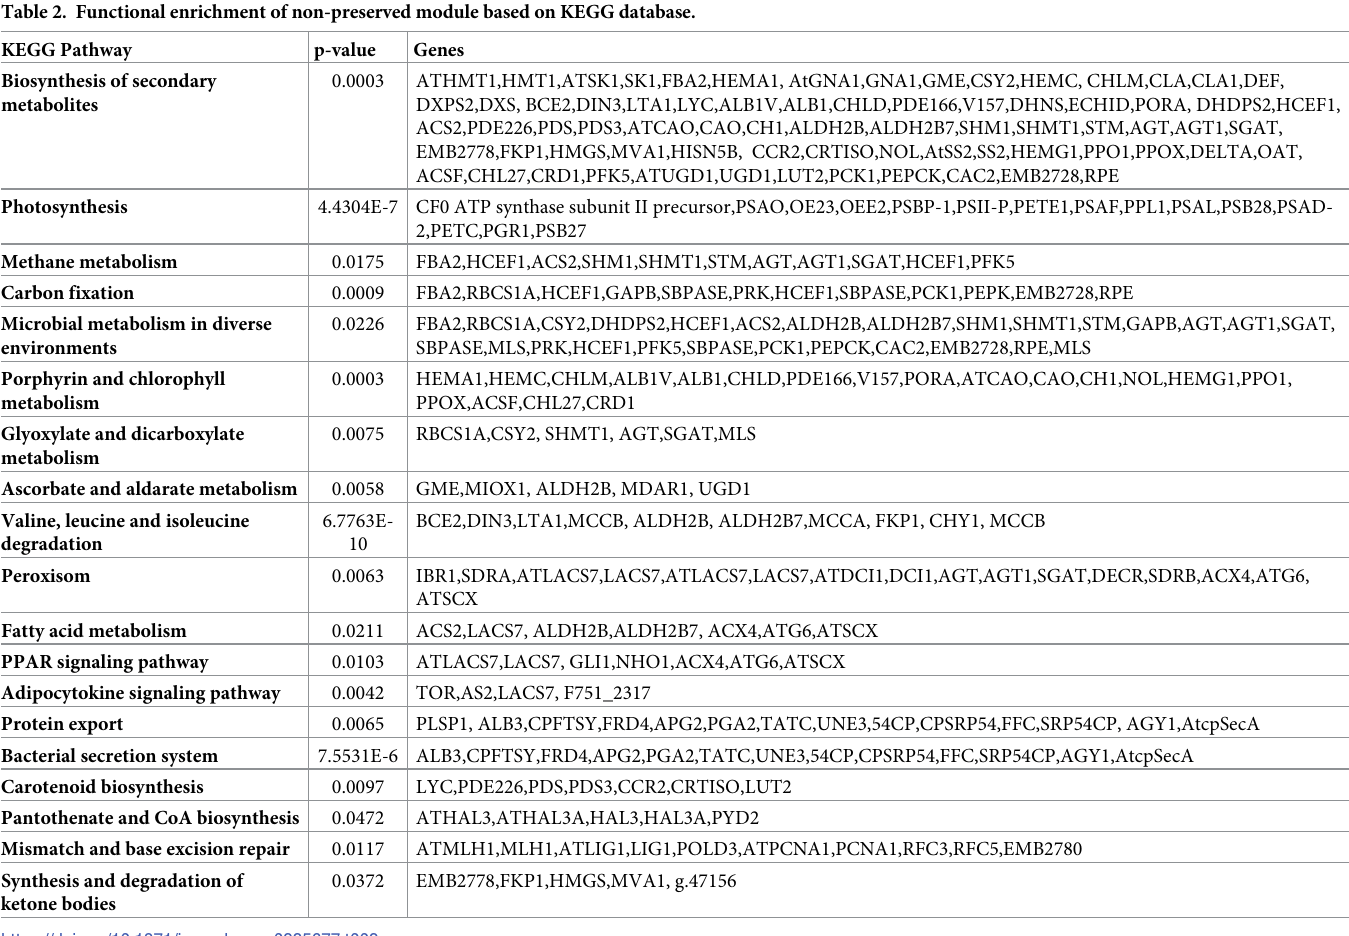
Table 2. Functional enrichment of non-preserved module based on KEGG